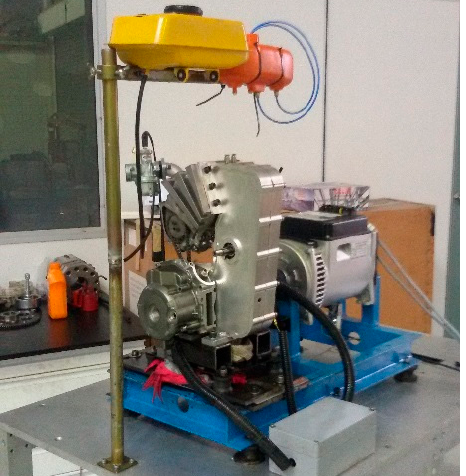
Figure 6. The crank-rocker engine and accessories mounted on the testbed.